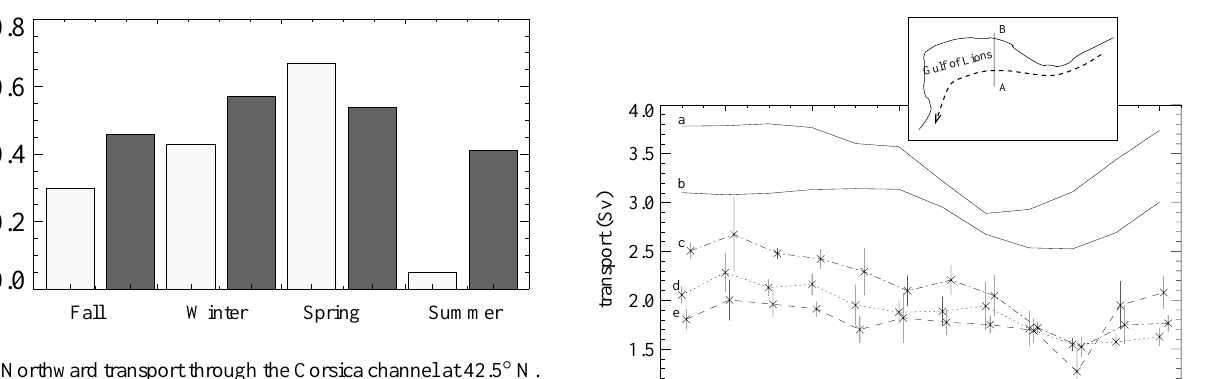
Fig. 7. Northward transport through the Corsica channel at 42.5 ◦ N. Light-shaded values correspond to measurements (Astraldi and Gasparini, 1992); dark-shaded values correspond to GM and RM values.